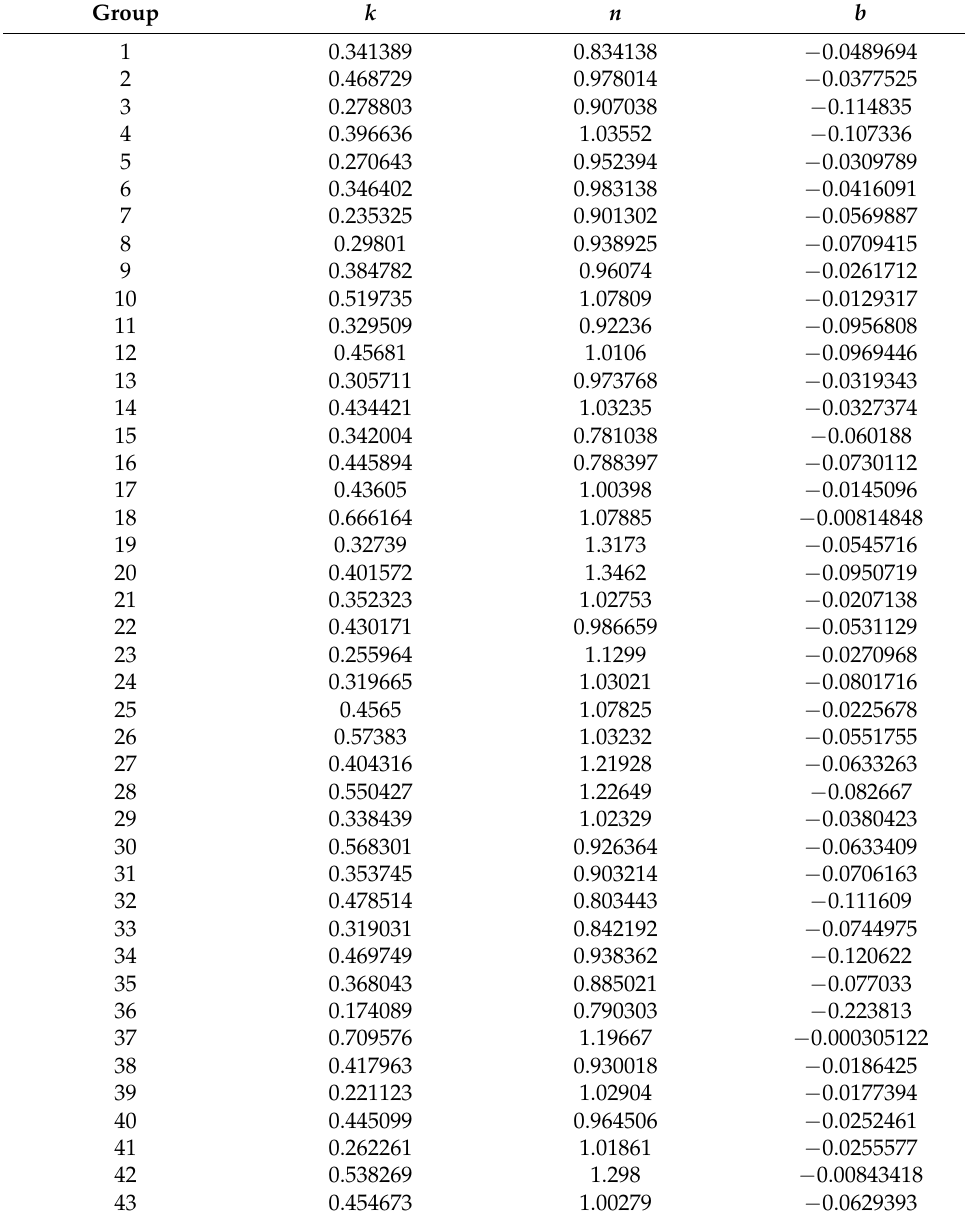
Table 11. Coefficients of the control group